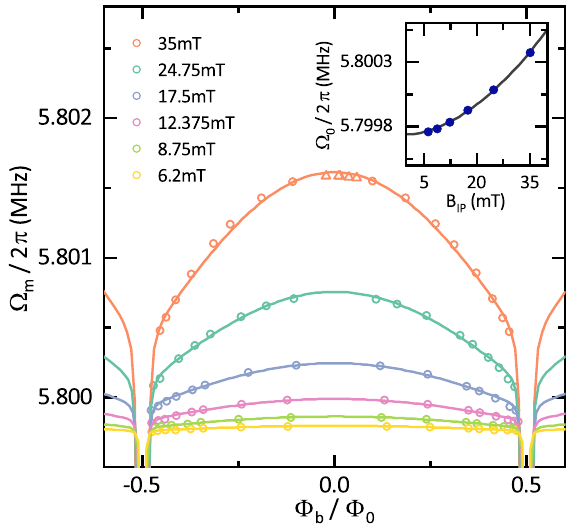
Figure 3. Flux- and field-dependence of the mechanical resonance frequency. Extracted mechanical resonance frequency as a function of the applied bias flux through the SQUID loop, measured at different in-plane fields B IP ranging from 6.2 to 35 mT. Open circles correspond to data gathered by measurement of the thermal motion, while triangular data points are acquired with a piezoelectric actuator resonantly driving the mechanical motion. Lines are fits to the data according to Eq. (2) with E J and (cid:31) 0 as the only free fit parameters. The inset shows (cid:31) 0 as a function of the applied in-plane field as extracted from the fits as well as a power-law fit (black line) revealing (cid:31) 0 ∝ B 1.81 IP . The increase suggests an additional contribution not included in the presented model and is discussed in the main text. Statistical error bars are smaller than the symbol